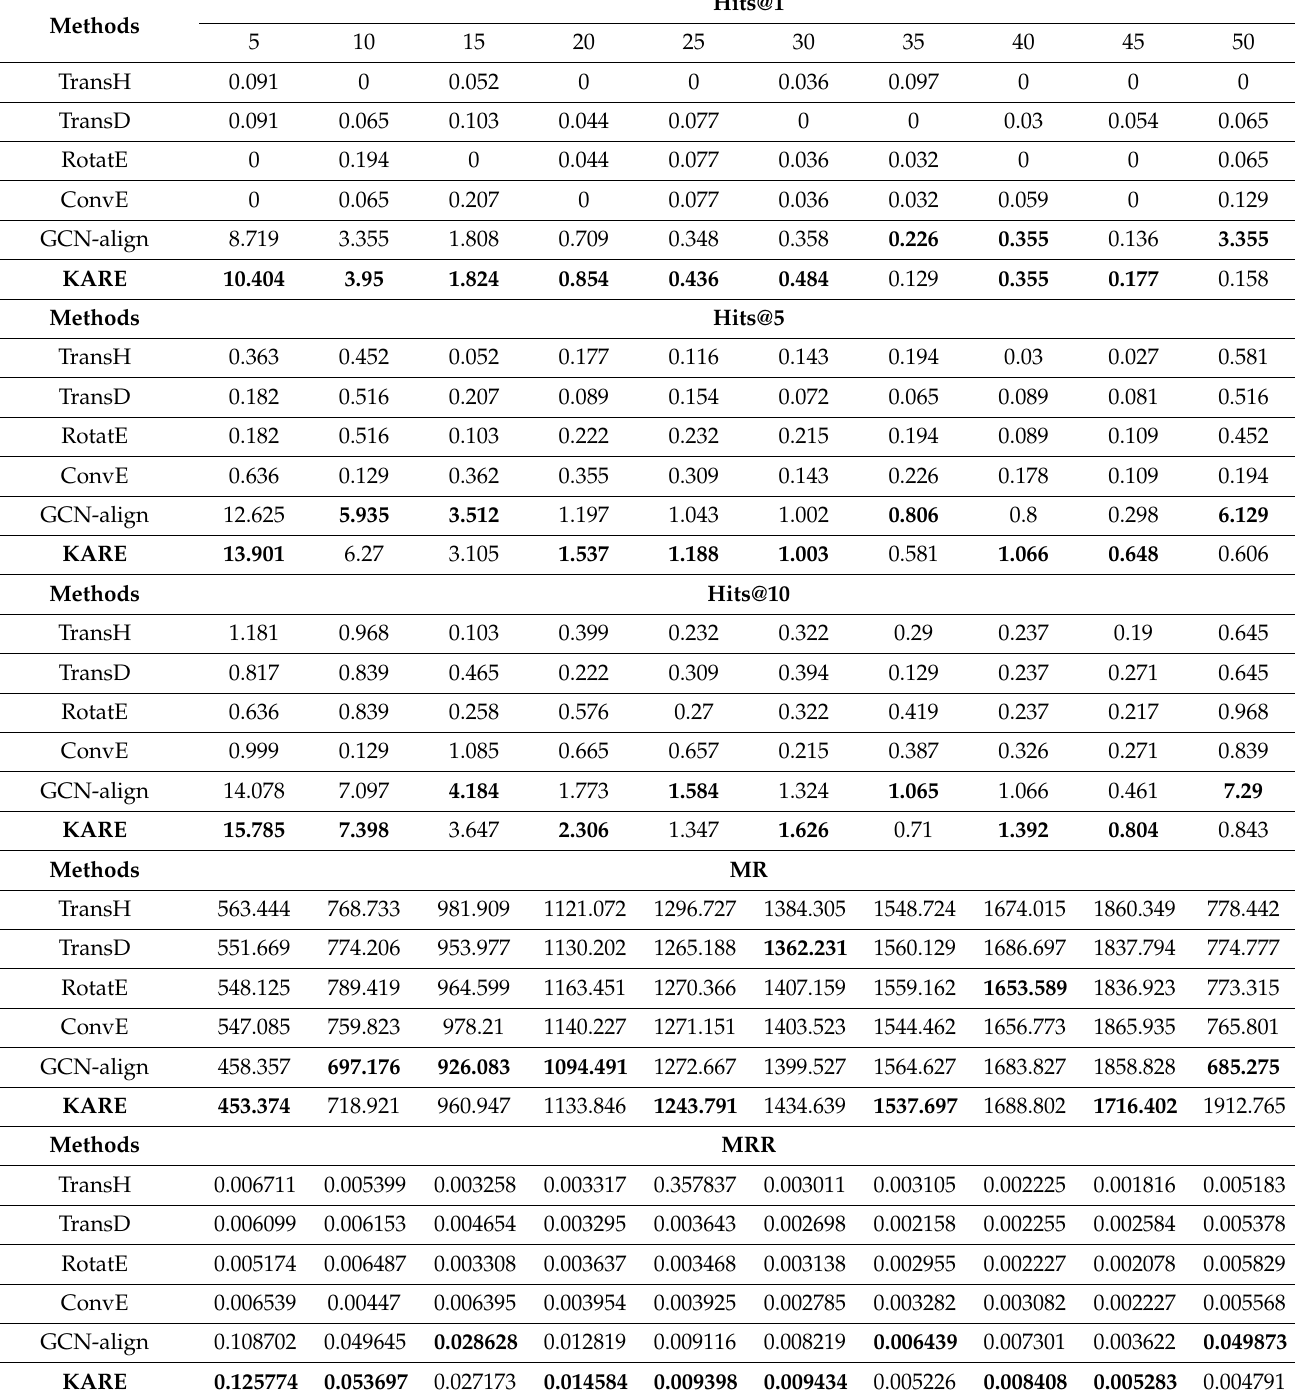
Table 3. Results of knowledge graph alignment with the sampling